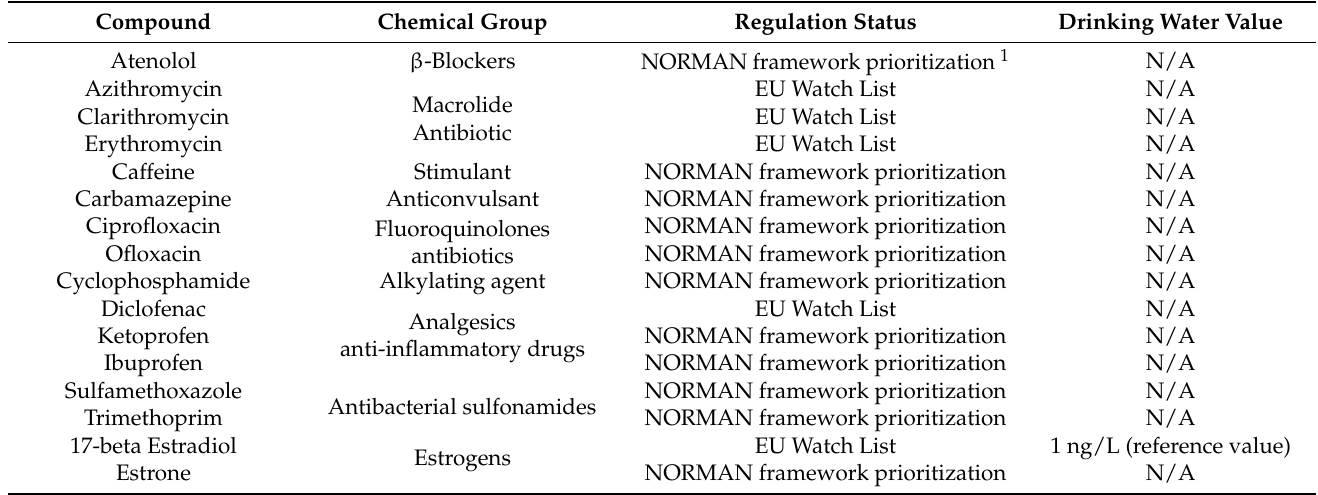
Table A1. Analysis parameters for the 16 target compounds.